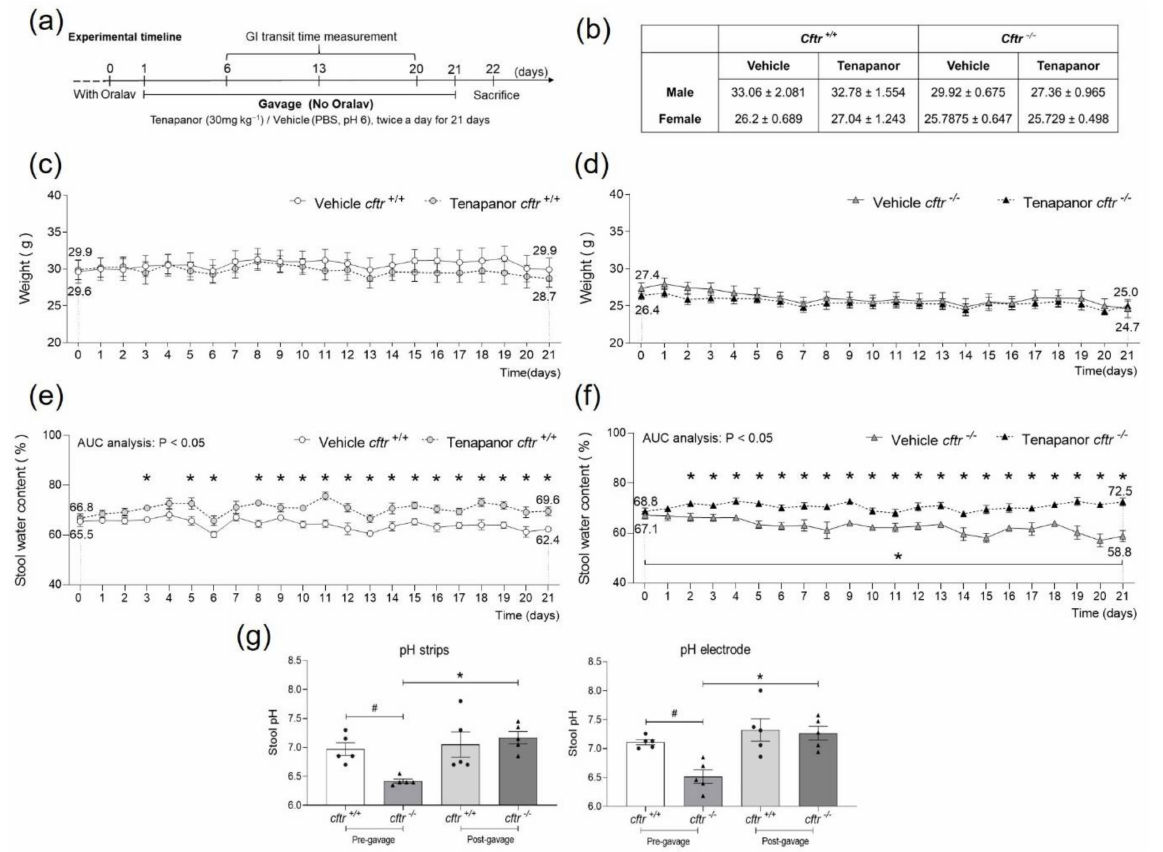
Figure 1. Effect of 3 week tenapanor treatment on body weight, stool water content, and stool pH in cftr +/+ and cftr − / − mice. ( a ) Schematic description of experimental protocol. ( b ) Initial body weight (grams) of the male and female mice that did or did not develop obstructions. ( c ) The body weight remained stable during the 3 week gavage period in the cftr +/+ mice and ( d ) slightly decreased in the cftr − / − mice, irrespective of treatment with tenapanor or vehicle. ( e ) A significantly higher stool water content was seen in the tenapanor-treated cftr +/+ and ( f ) cftr − / − mice in comparison to the vehicle-treated groups. ( g ) Increased stool alkalinity 3 h post-gavage with tenapanor. Each dot/triangle represents one mouse. cftr +/+ : n = 10 in both tenapanor-treated and vehicle-treated groups; cftr − / − : n = 12 in the tenapanor-treated and n = 13 in the vehicle-treated group. Data are represented as means ± SEM. # is used to represent the statistical analysis performed between the two different genotypes and * is used to represent the statistical analysis performed between the vehicle and tenapanor groups and between the same genotype, pre- and post-tenapanor gavage. # and *, p <